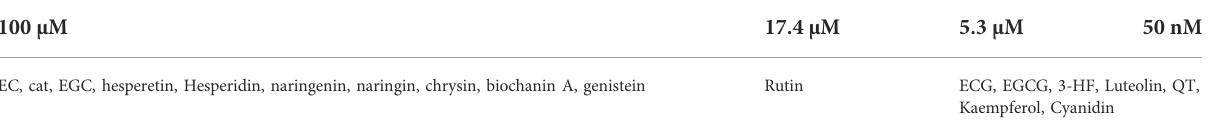
Binding af fi nity